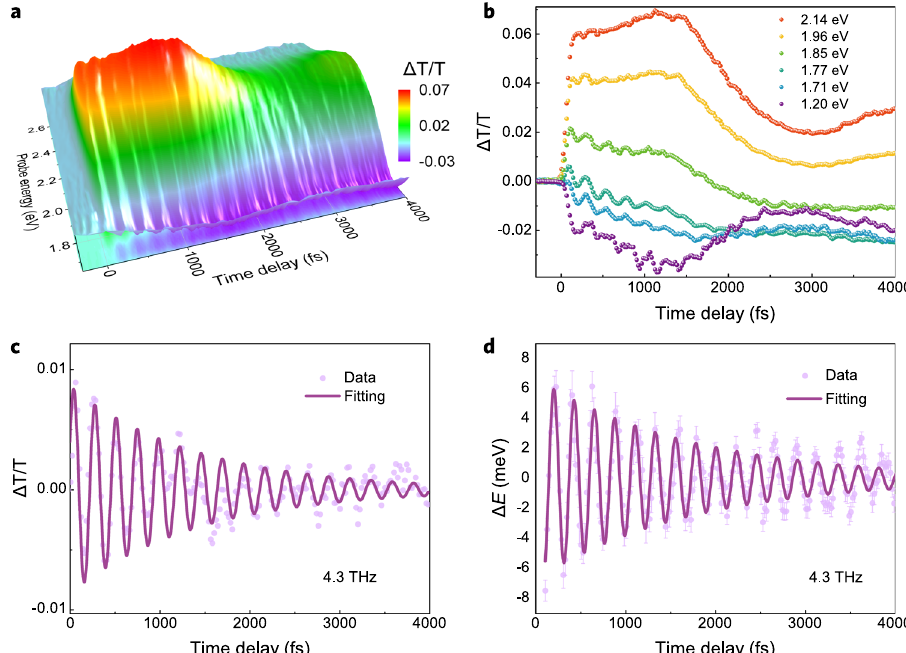
Fig. 3 Real-time observation of intralayer coherent vibrational dynamics of PdSe 2 . a 3D transient absorption spectrum in terms of differential transmission Δ T / T as a function of time delay and probe photon energy on the femtosecond timescale. b The corresponding time- dependent dynamic process with different probe photon energies. c Coherent phonon dynamics at 4.3 THz probed at 1.71 eV. The oscillatory components of the transient absorption spectrum are extracted after subtracting the population dynamics. d Extracted oscillatory components of Δ E as a function of pump – probe time delay. The fi tted lifetime is 1.73